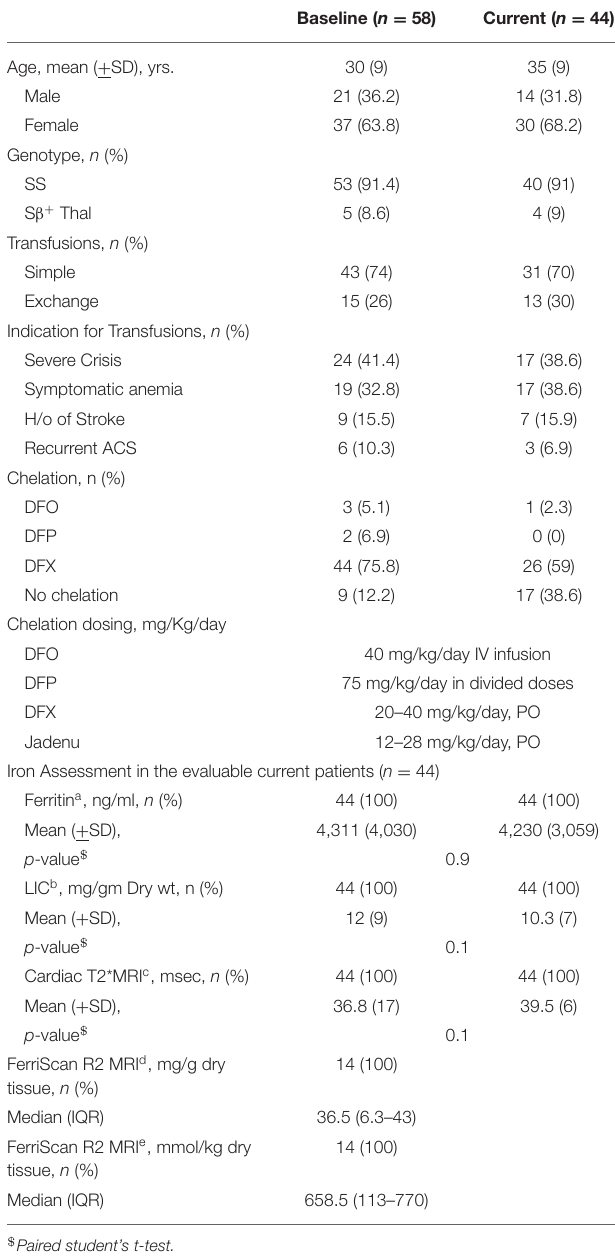
TABLE 1 | Patient